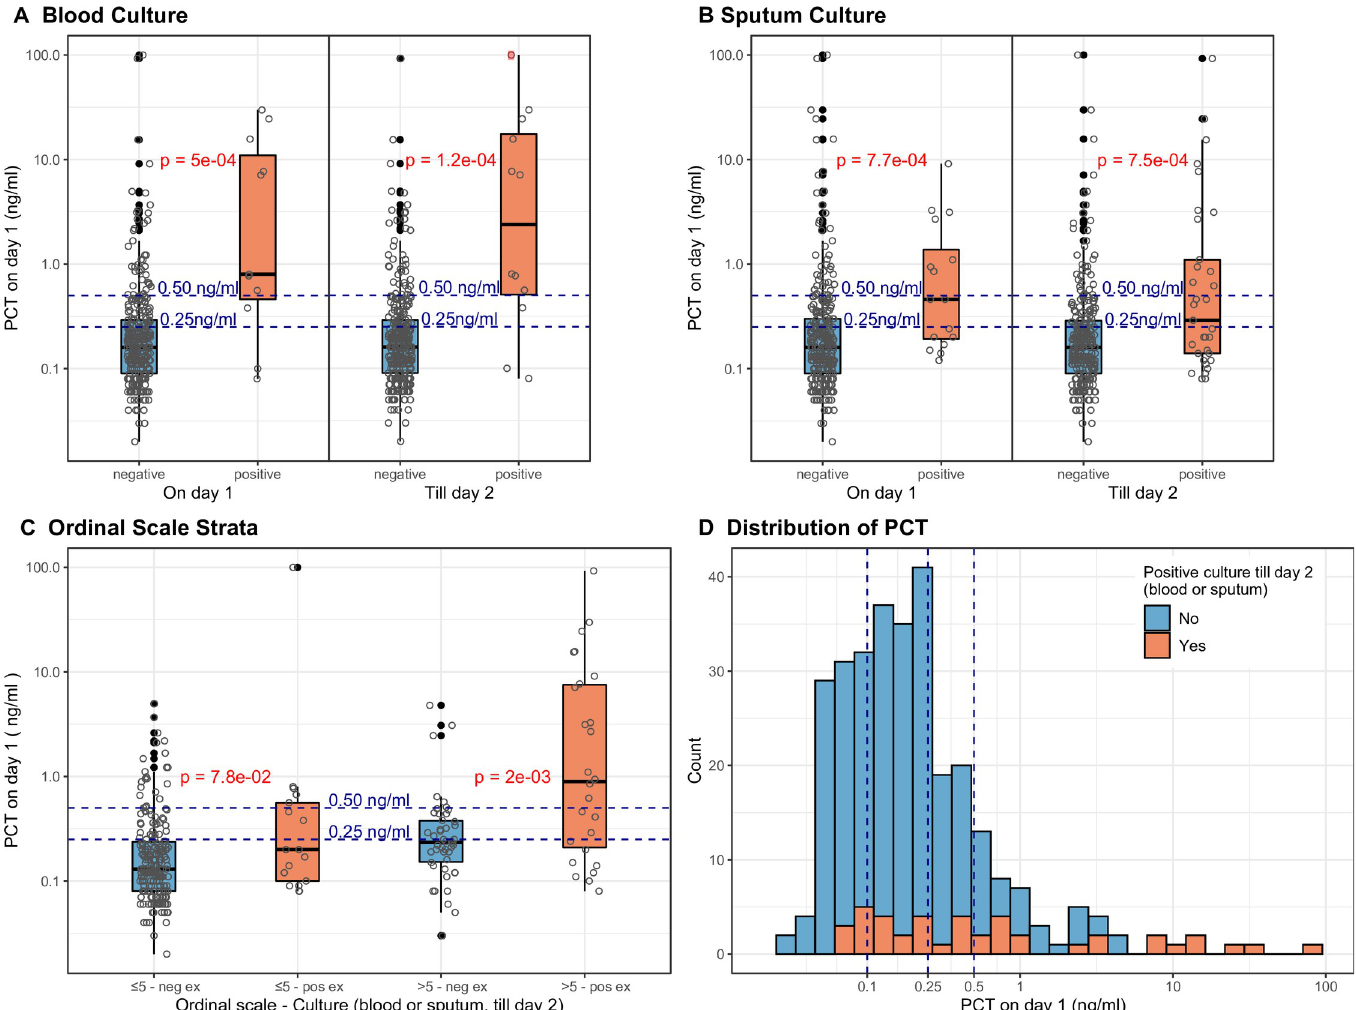
Fig 2. Distribution of baseline PCT in microbiologic strata. Blood (Panel A) and sputum (Panel B) cultures were recorded from day 1 through day 2 of hospitalization. Values shown as open circles with horizontal scatter and summarized by box plots, values beyond whiskers additionally represented by filled circles. Distribution of baseline PCT in ordinal scale and microbiologic strata (Panel C). Stacked histogram of baseline PCT according to microbiology (Panel D).